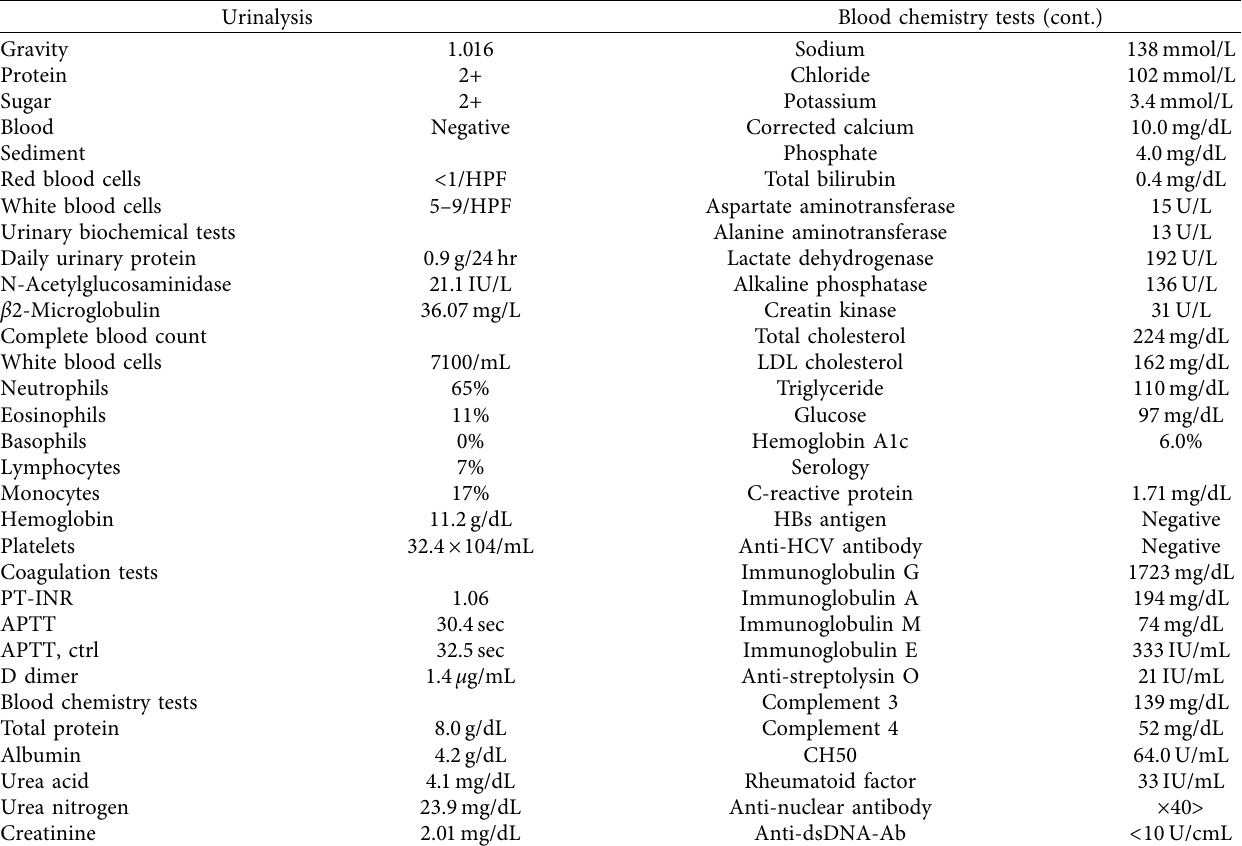
Table 1: Laboratory findings of case 1.